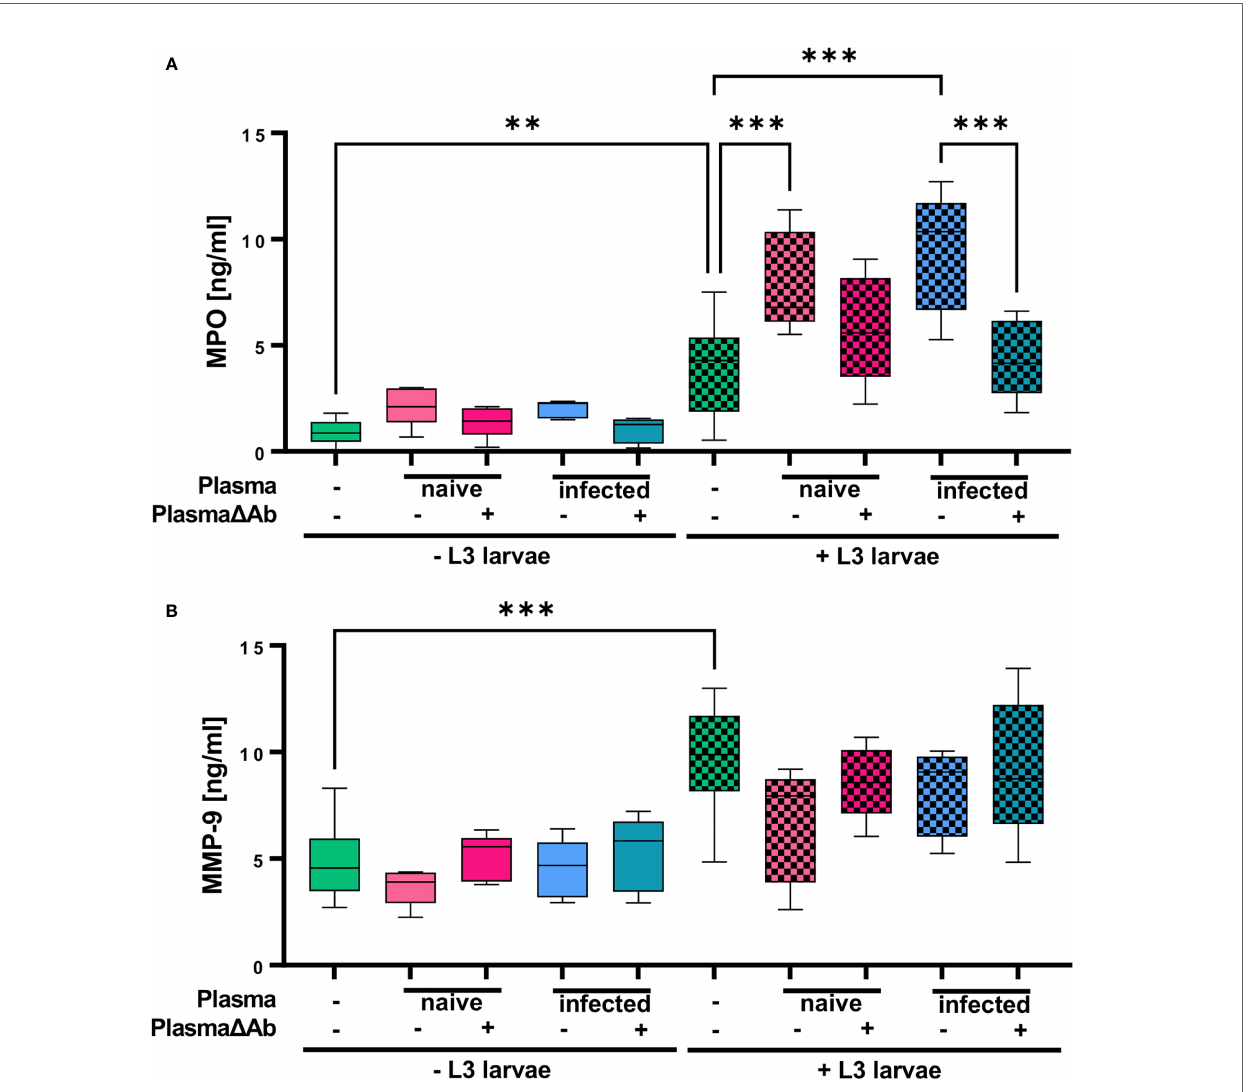
FIGURE 6 | S. ratti L3 induce release of MPO and MMP-9-containing granules. (A) MPO and (B) MMP-9 concentration measured in the supernatant of neutrophils stimulated with plasma from S. ratti -infected or naive animals, S. ratti L3 larvae alone or in combination with plasma. Plasma has been left untreated or antibody- depleted ( D Ab). Shown are box plots with tukey with n=5. One out of two independent experiment. One-Way ANOVA with Bonferroni post-hoc test. Only statistically signi fi cant comparisons are depicted, all other comparisons were statistically not signi fi cant. p < 0.01 **, p < 0.001